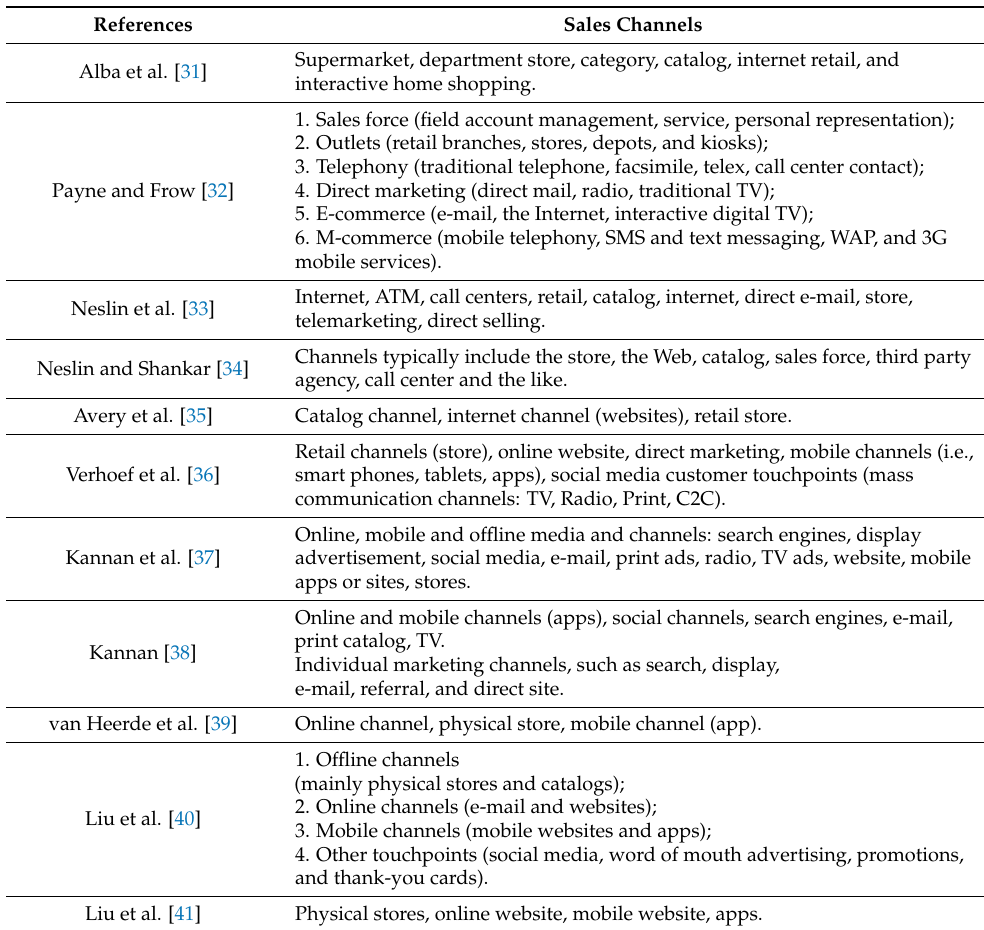
Table 1. Theoretical review of sales channels.